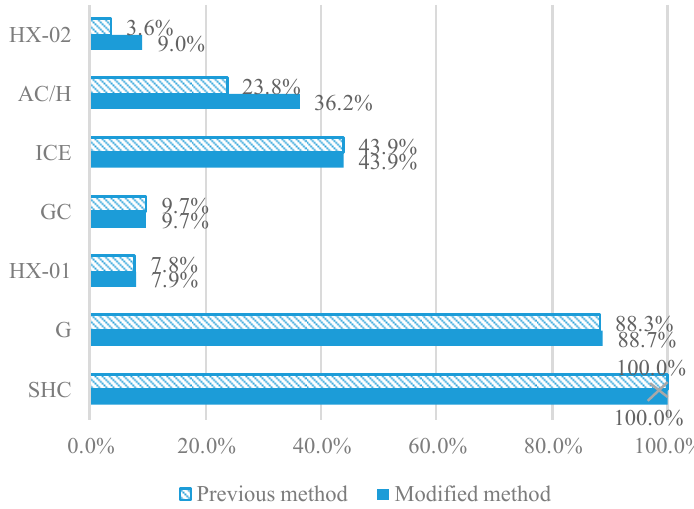
Figure 6. Exergoeconomic factors of components calculating in two methods.